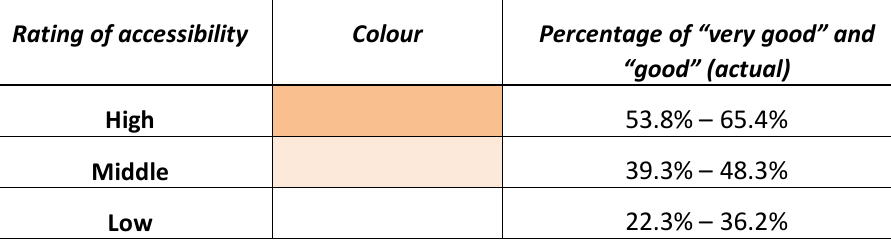
Table 16.1 : Scheme for the evaluated accessibility of different types of